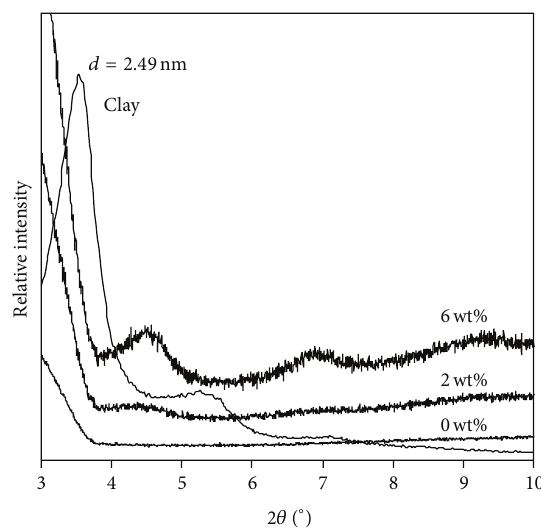
Figure 2: XRD patterns of the UP/glass fiber/clay nanocomposites with different clay